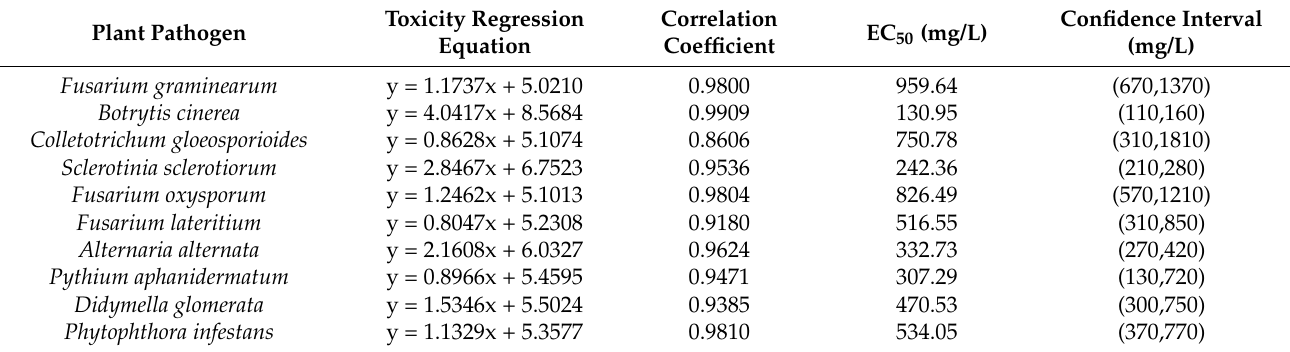
Table 1. Toxicity test results of CX plant extracts against 10 kinds of plant